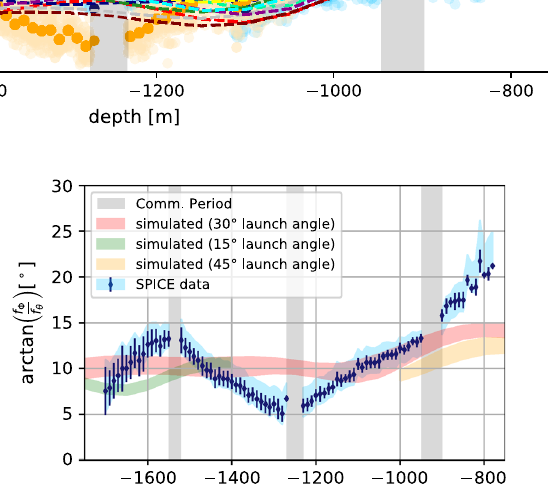
Fig. 11 Measured fluence at the ARIANNA station and the expected fluence after propagating the anechoic chamber pulses through the birefringence model. The dominant θ component was downscaled by a factor of 5 for better visibility. The θ and φ components of the ten pulses are represented by solid and dashed lines respectively. The gray areas mark communication periods during which no data was taken